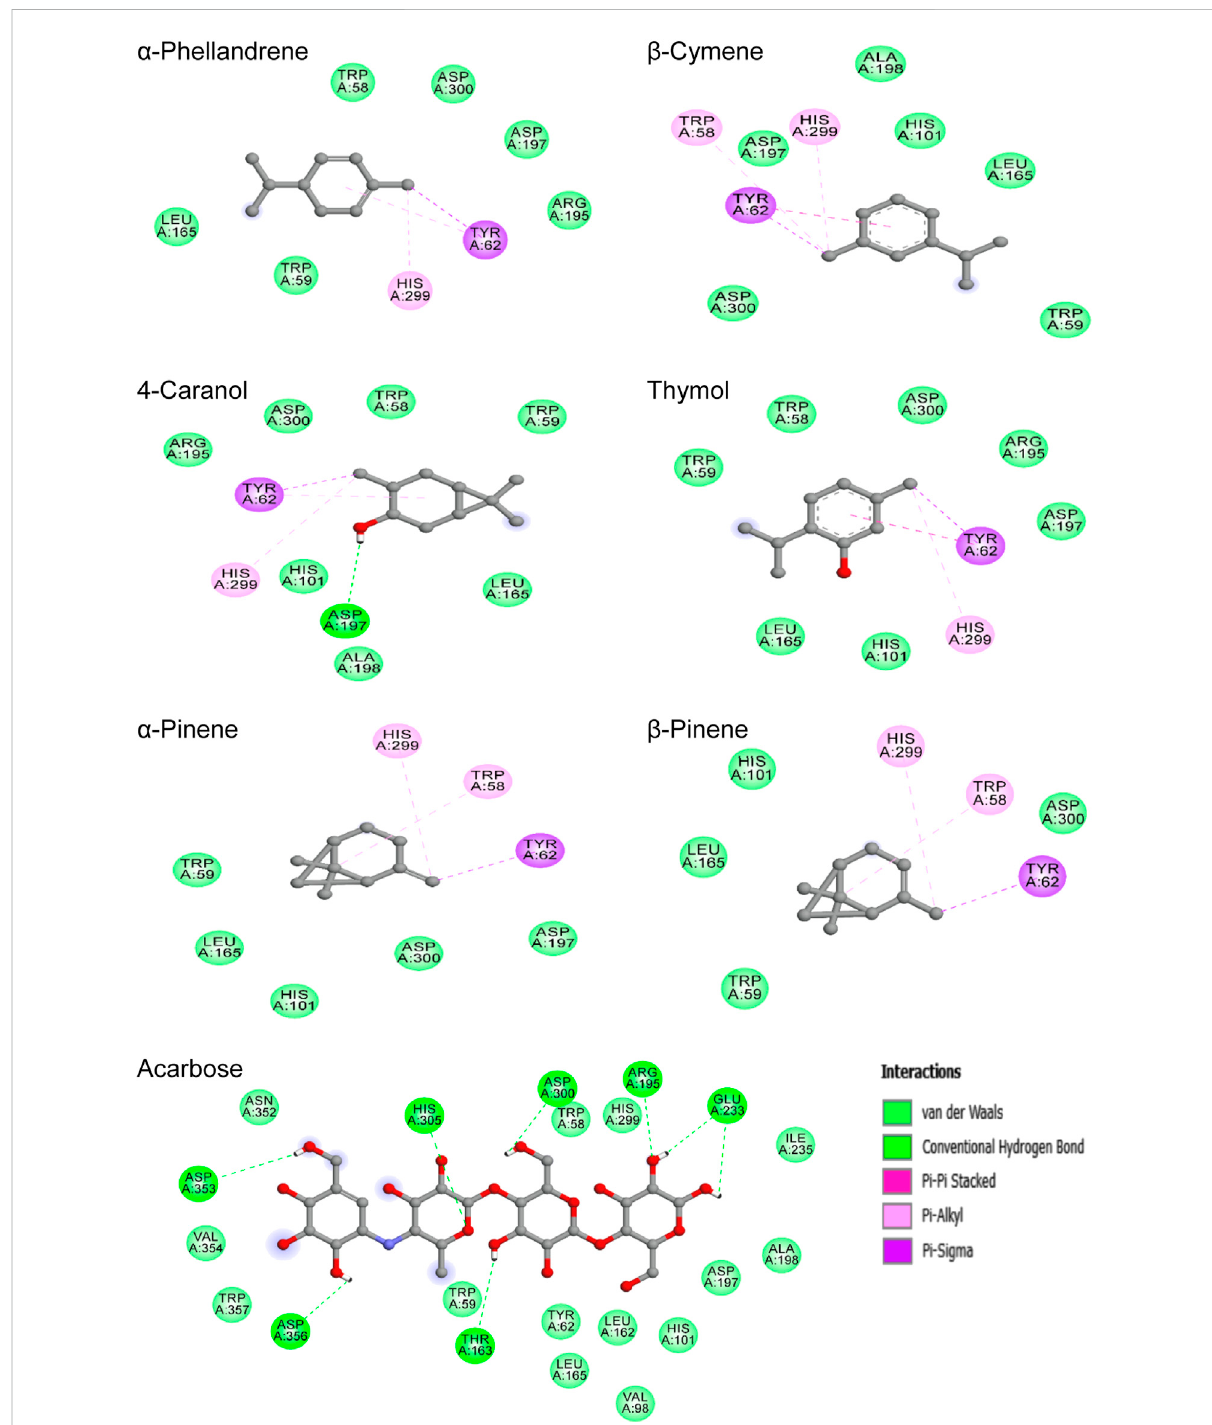
FIGURE 6 2D-representations of the best-docked poses of the studied ligands in the active pocked of human pancreatic α -amylase.